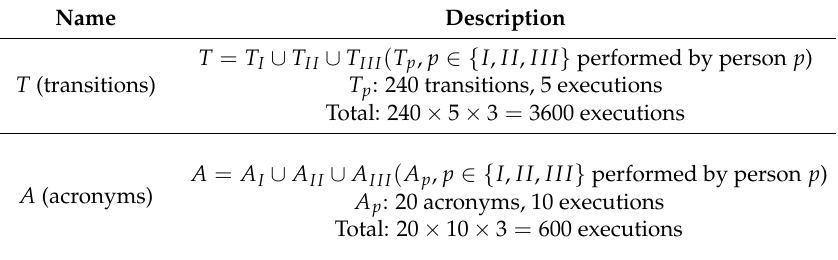
Table 1. Content of the prepared dataset (depth images registered by Kinect 2.0).